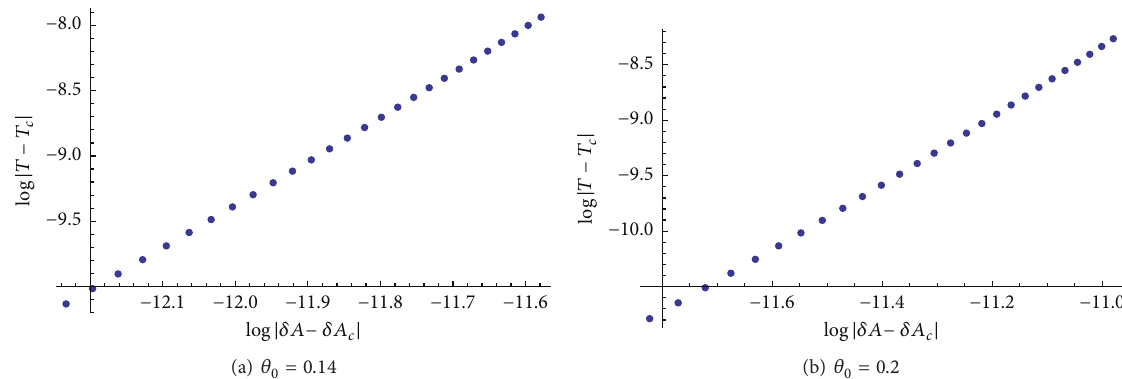
Figure 8: Relation between log |𝑇 − 𝑇 𝑐 | and log |𝛿𝐴 − 𝛿𝐴 𝑐 | near the critical point of second-order phase transition for different 𝜃 0 .